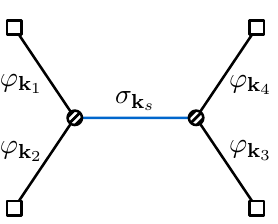
Figure 3 . The 4-point function mediated by a massive scalar boson σ at tree level. coupling produces a two-point mixing between ϕ and χ in the form of a 3 ϕ 0 χ . If the field χ is heavy, we can integrate it out and this produces an effective coupling ϕ 0 2 σ .